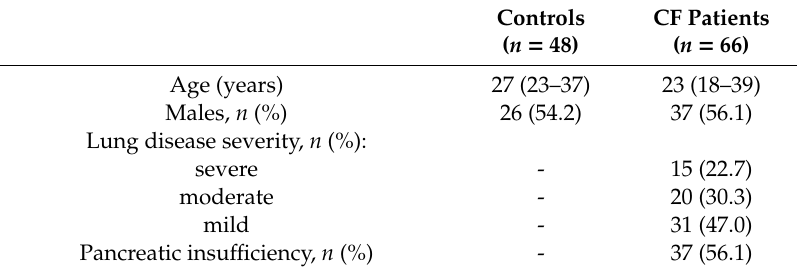
Table 1. Demographic and clinical data of the study population.